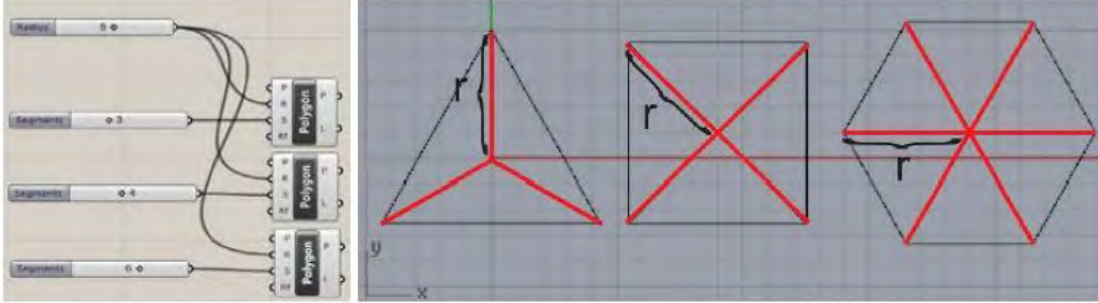
Figure 3. Parametric Optimization on module